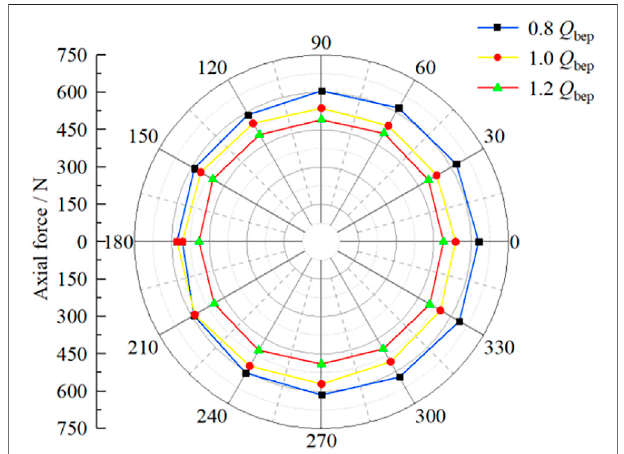
FIGURE 9 | Transient changes of axial force on the impeller in a rotating cycle.